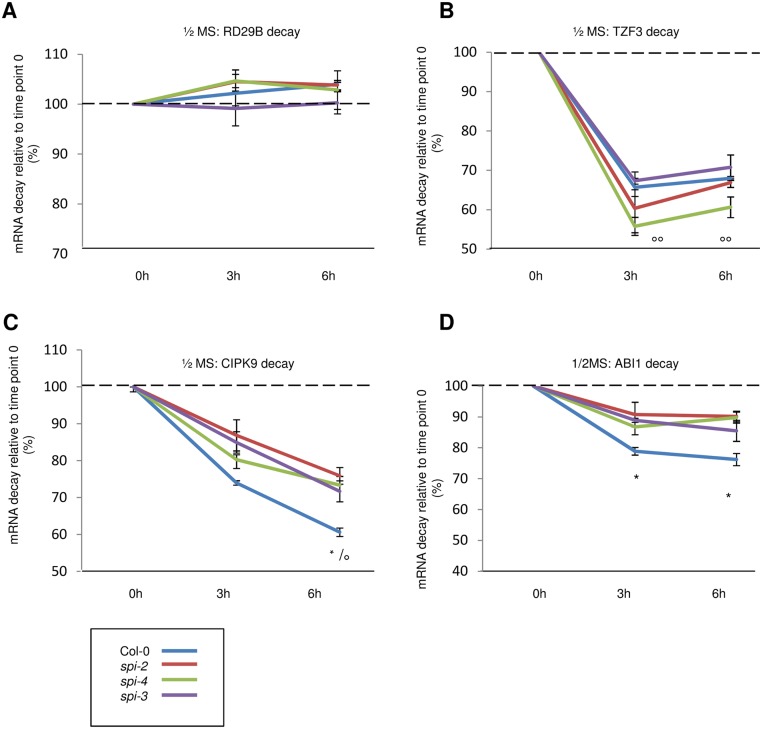
mRNA decay is not accelerated in spi mutants under nonstress conditions.mRNA stabilities (in %) were determined 3 h and 6 h after application of Actinomycin D (ActD), relative to time point 0 under nonstress conditions for RD29B (A), TZF3 (B), CIPK9 (C), and ABI1 (D). Data denote the average from three independent biological and two technical replicates. Error bars represent the standard error of the mean. Two-tailed student’s t tests were performed to compare 18S rRNA normalized expression levels either of spi alleles with that of wild-type (* p < 0.05; ** p < 0.01 of all spi alleles), or of ActD-treated samples with that of untreated samples (time point 0) (° p < 0.05; °°
p < 0.01 of all treated samples).